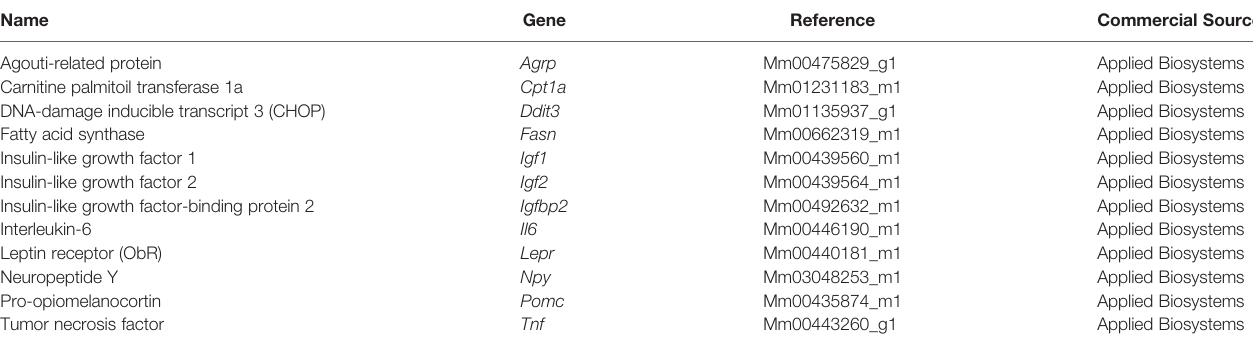
TABLE 2 | List of TaqMan probes used for